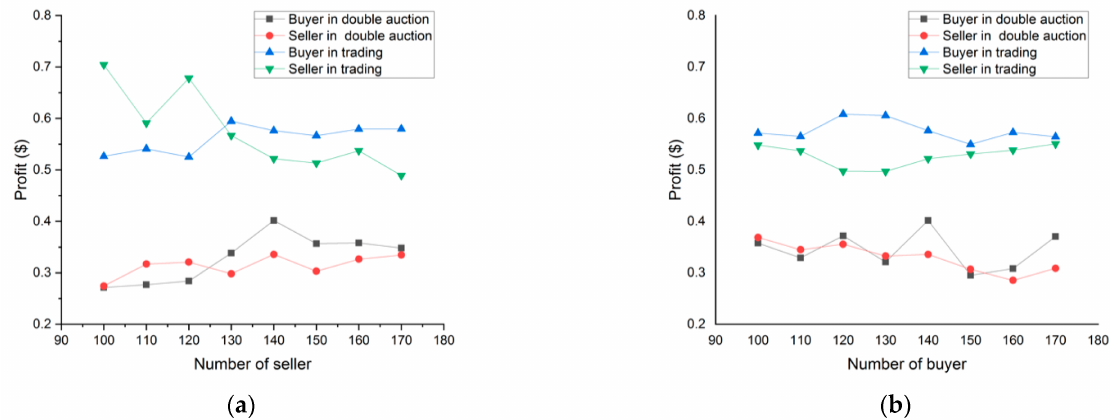
Figure 7. ( a ). Profit with the change of the number of sellers. ( b ). Profit with the change of the number of